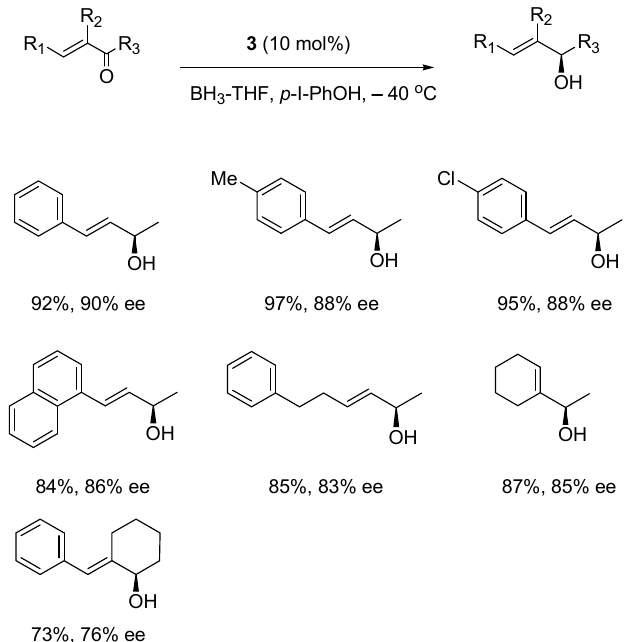
Scheme 9. Asymmetric reduction of α , β -enones using 3 and p -iodophenoxyborane. All reactions